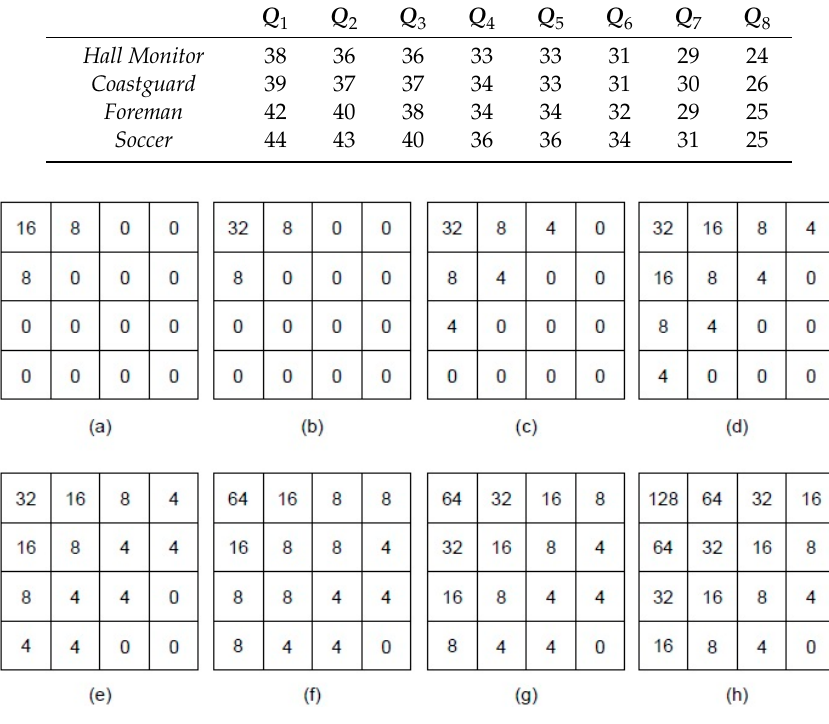
Reference quantization parameters (QPs) applied for the key frame coding in the JEM-DVC codec.